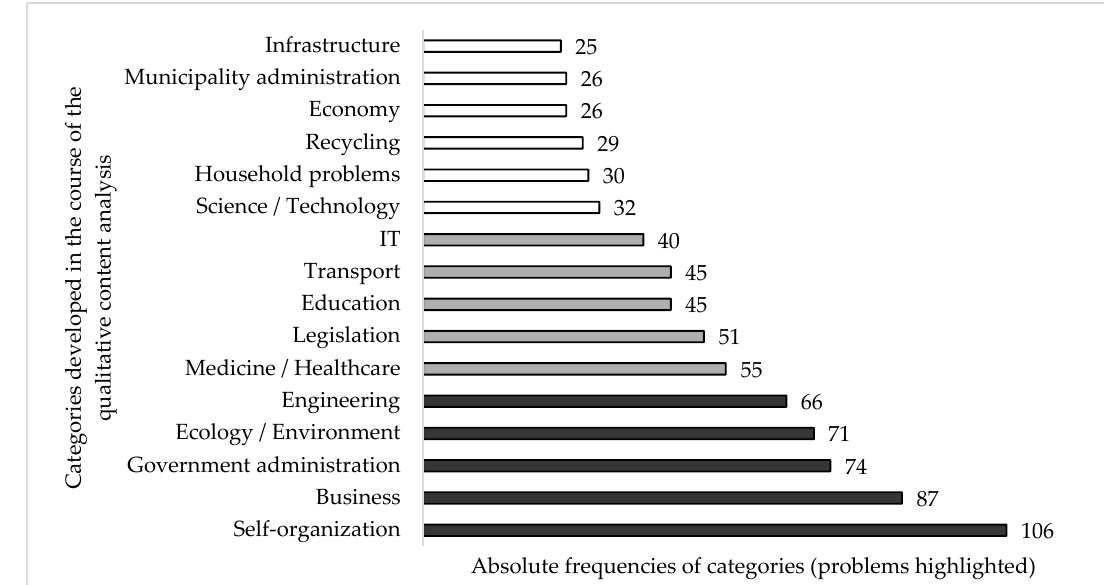
Figure 1. Distribution of the problem groups by the frequencies they were spoken about.